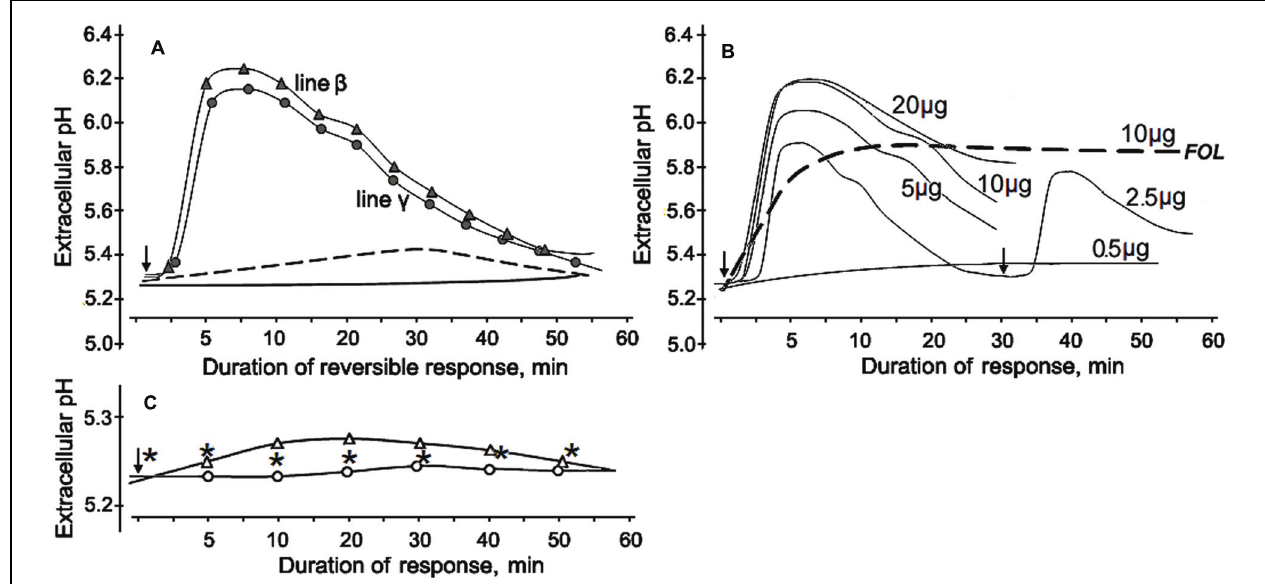
FIGURE 6 | Alkalinization of the incubation medium by cultured tomato cells in response to CS-20 proteins contained in fraction V, which reduced Fusarium wilt severity in tomato seedlings. (A) Profiles of extracellular pH change in suspensions of two cell lines after addition of the lyophilized fraction V to a final concentration of 10 μ g/ml. Cell response (line β ) to the fraction pretreated with proteinase K shown by dotted line. The solid line shows extracellular pH of non-treated cells. (B) Dose-rate effect of the fraction V isolated from CS-20 on tomato cell line γ . Numerals near curves show final concentrations ( μ g per ml) of the lyophilized fraction V in the tomato cell suspension. Re-stimulation of the reversible response is exemplified for a concentration of 2.5 μ g/ml. Dotted line illustrates the irreversibility of alkalinization response to preparation from the pathogenic FOL (strain F37), obtained by the same procedures that were applied to isolate fraction V from CS-20. (C) The extracellular pH values after addition of inactive fractions III (white circles) or IV (white triangles) at a concentration of 10 μ g/ml. Asterisks show extracellular pH of non-treated cells. Arrows indicated starting point of treatments. The representative data are out of one of three experiments with the protein fraction V samples independently isolated from CS-20 culture.